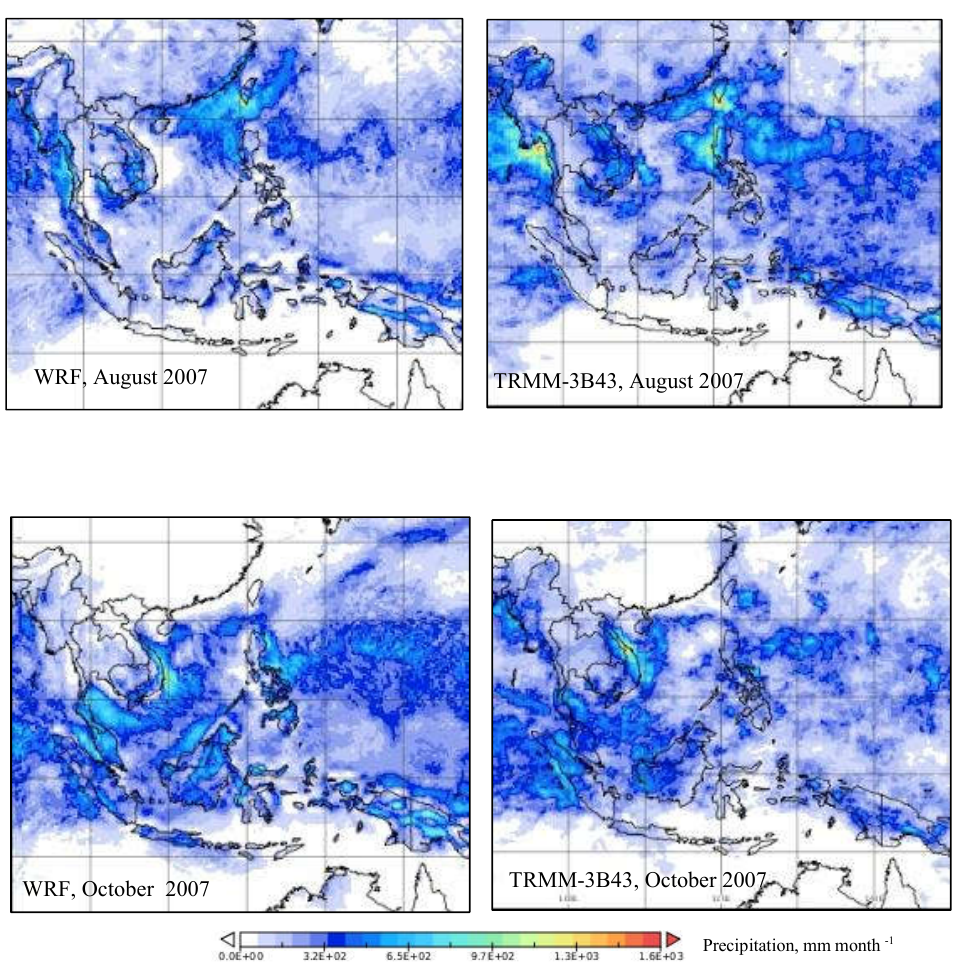
Figure 2. Comparison of modeled monthly precipitation and the TRMM-3B43 dataset in August and October